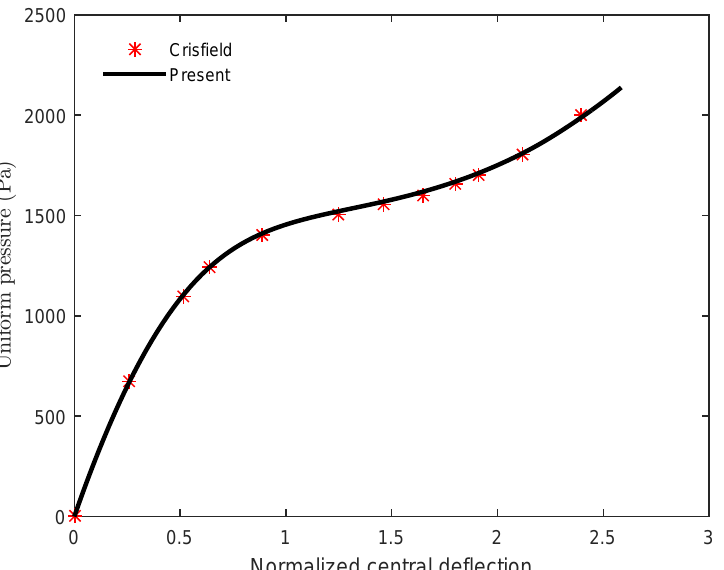
Figure 4. Normalized central deflection ˆ w of the fully clamped isotropic cylindrical panel with h = 3.175 mm, κ =